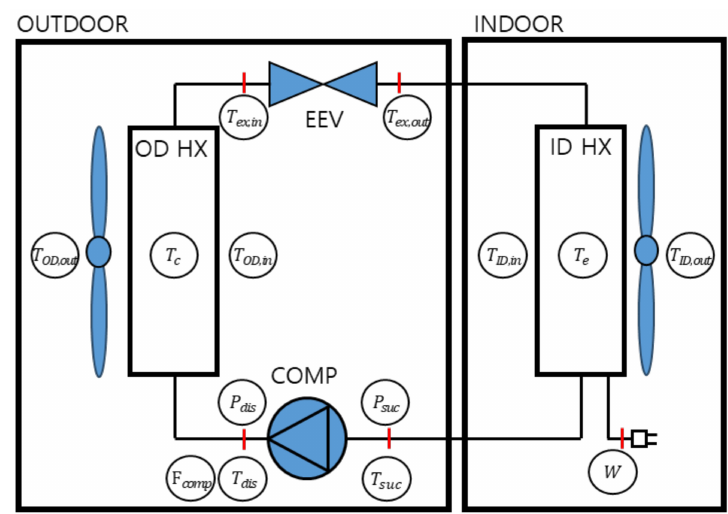
Figure 1. Schematic diagram of experimental equipment.